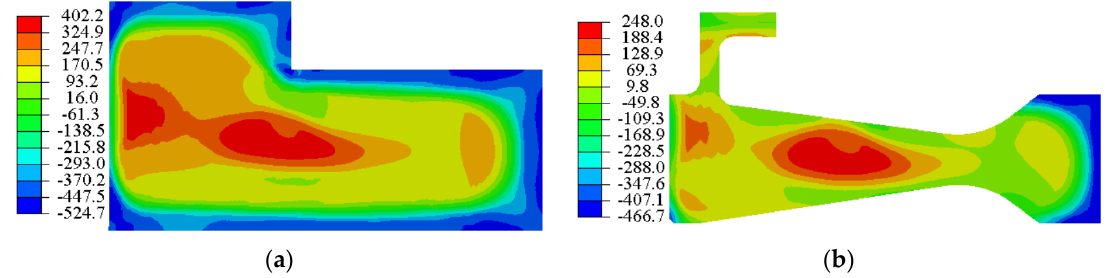
Figure 7. Residual hoop stress after AC. ( a ) Rough machined workpiece ( b ) Finishing disc. Figure 9. Residual hoop stress after WQ. ( a ) Rough machined workpiece ( b ) Finishing disc.